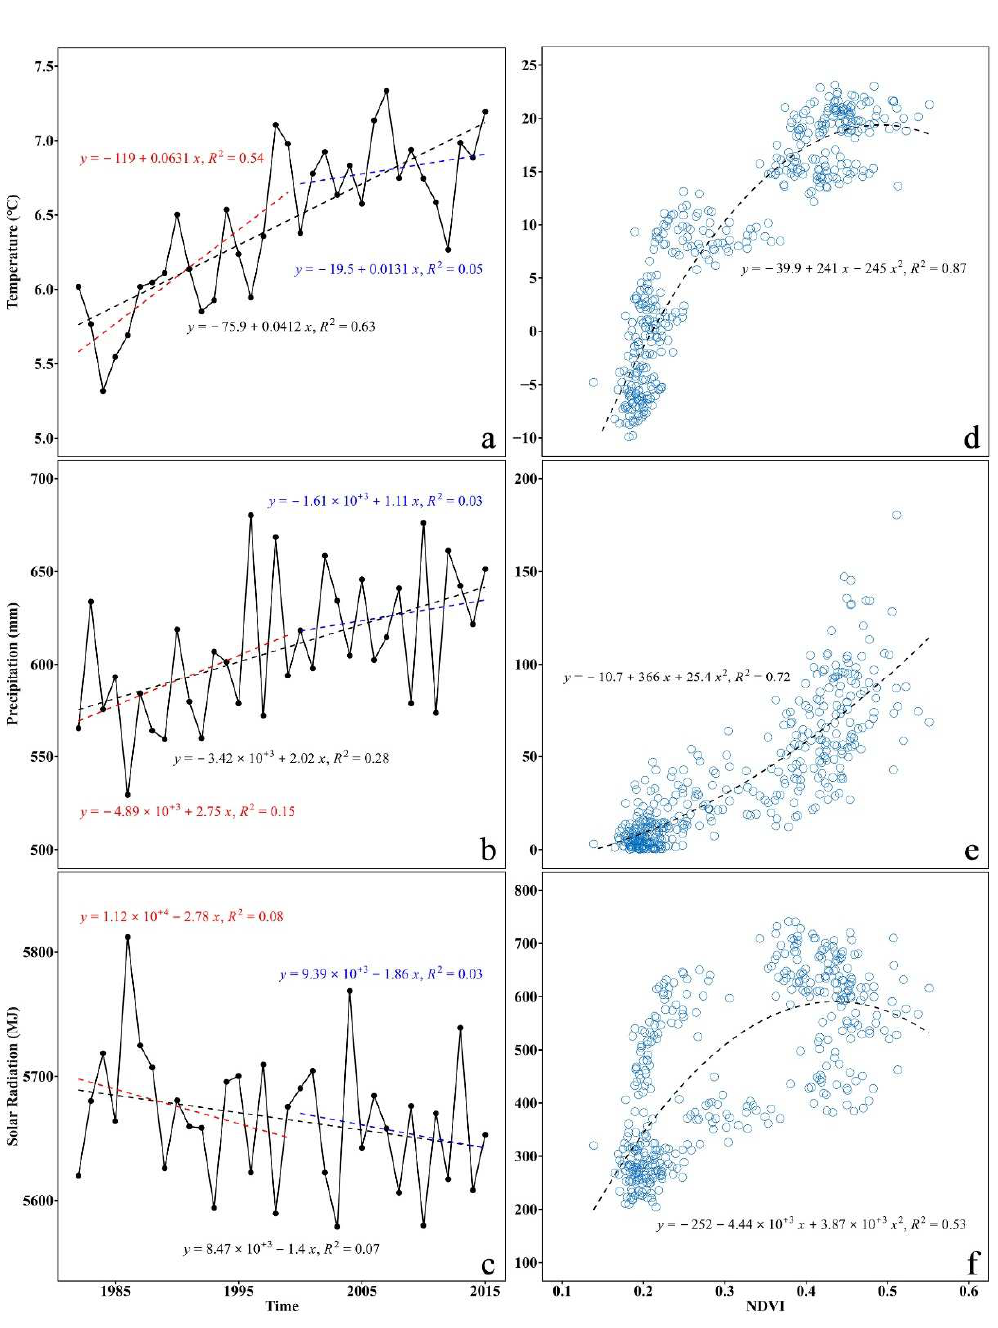
Figure 8. Trends of climatic factors variation and its relations to NDVI changes. The left panel represents interannual variations in ( a ) temperature, ( b ) precipitation, and ( c ) solar radiation over different periods. The right panel represents the relationship between NDVI and ( d ) temperature, ( e ) precipitation, and ( f ) solar radiation.